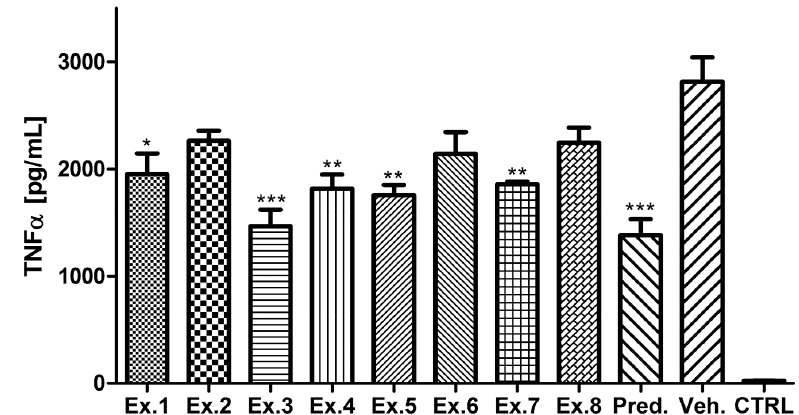
Figure 1. TNF- α production inhibitory activity of Scorzonera species. The cells were pretreated with extracts 1–8 (Ex. 1–8) (25 μ g/mL), and prednisone (1 μ M), or the vehicle (Veh., DMSO) only. After 1 h